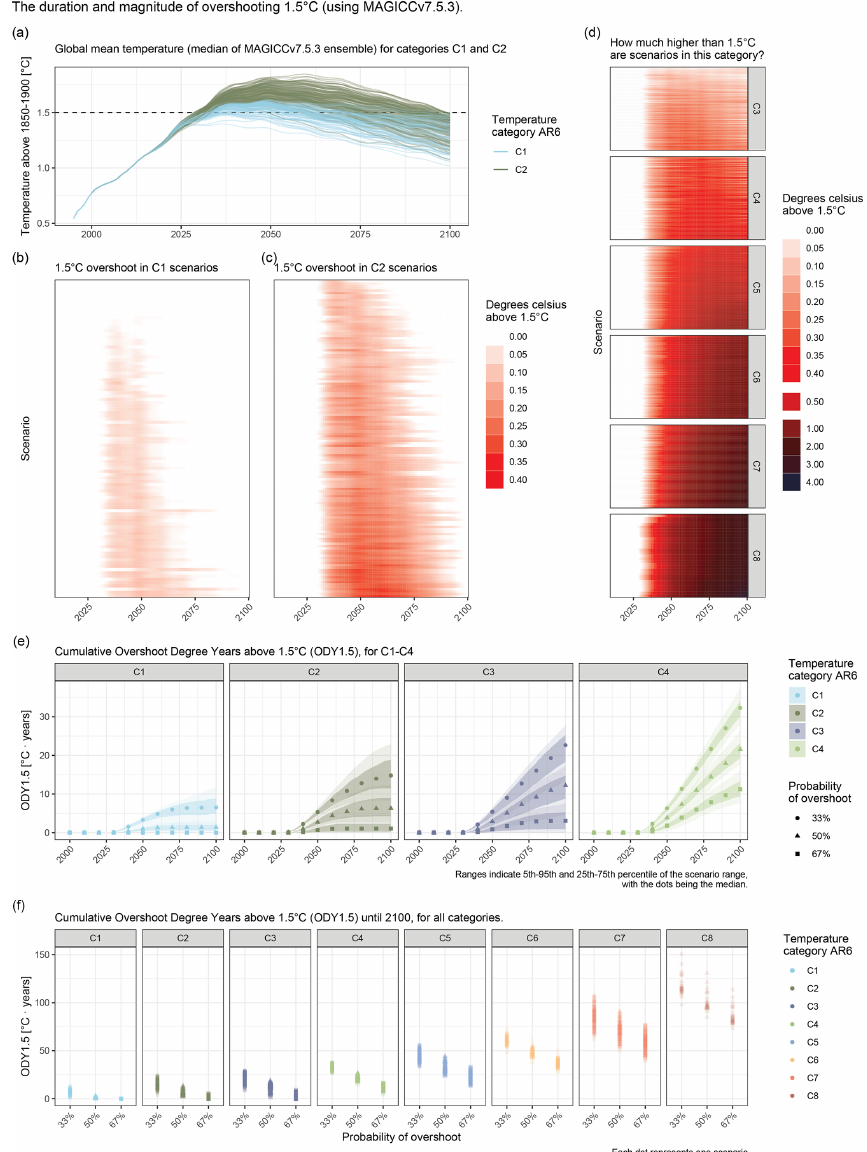
Figure 5. The duration and magnitude of overshoot and exceedance of 1.5 ◦ C global warming above 1850–1900 for scenarios in the AR6 temperature categories. Panel (a) : projected median global mean surface temperature for scenarios in C1 and C2. Panel (b) – (c) : magnitude and duration of the overshoot of 1.5 ◦ C in the C1 and C2 scenarios. Panel (d) : magnitude of 1.5 ◦ C exceedance of scenarios in C3–C8. For panel (b) – (d) , scenarios along the y axis are sorted by total ODY 1 . 5 until 2100. Panel (e) : projected increase in ODY 1 . 5 over time for temperature categories C1–C4 at 33%, 50%, and 67% probabilities. Panel (f) : projected cumulative exceedance of 1.5 ◦ C expressed